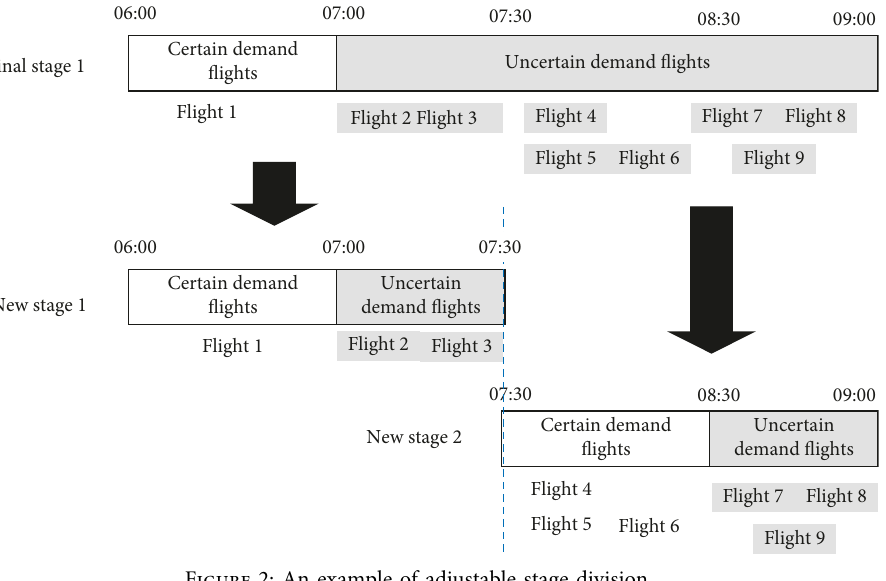
Figure 2: An example of adjustable stage division.